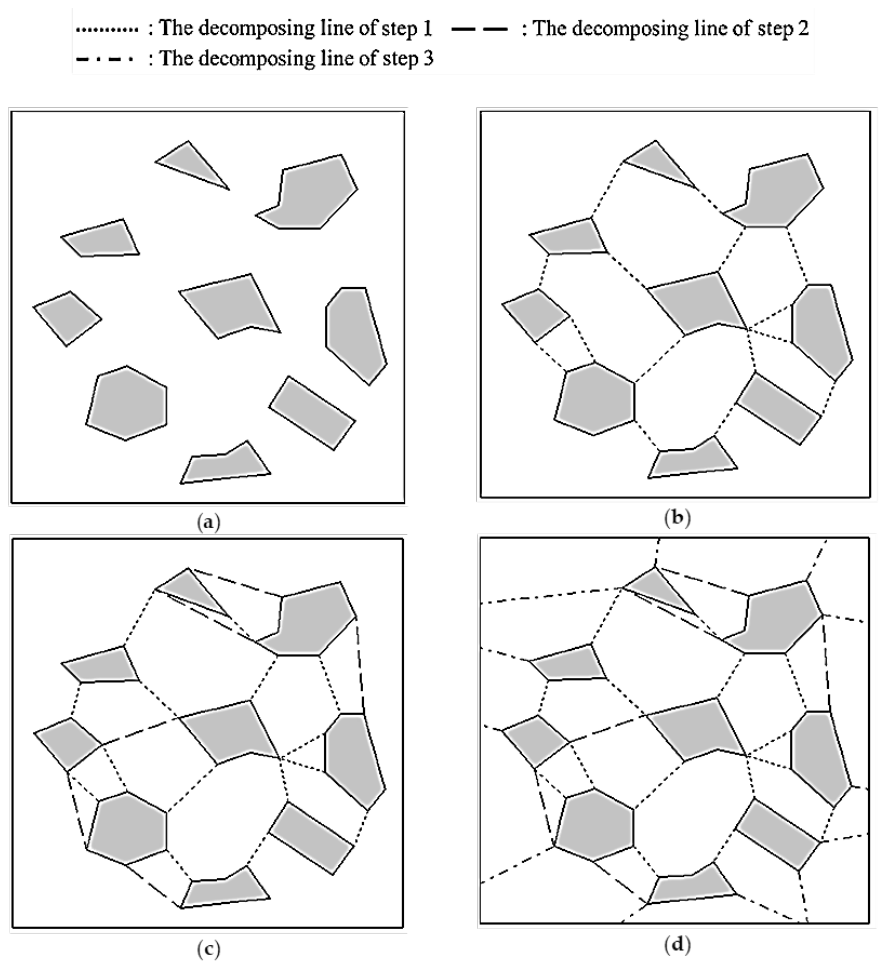
Figure 6. Decomposition results of each step in the modified Opposite Angle-Based Exact Cell Decomposition (OAECD) algorithm after the EDP algorithm: ( a ) Environment; ( b ) Result of step 1; ( c ) Result of step 2; ( d ) Result of step 3.